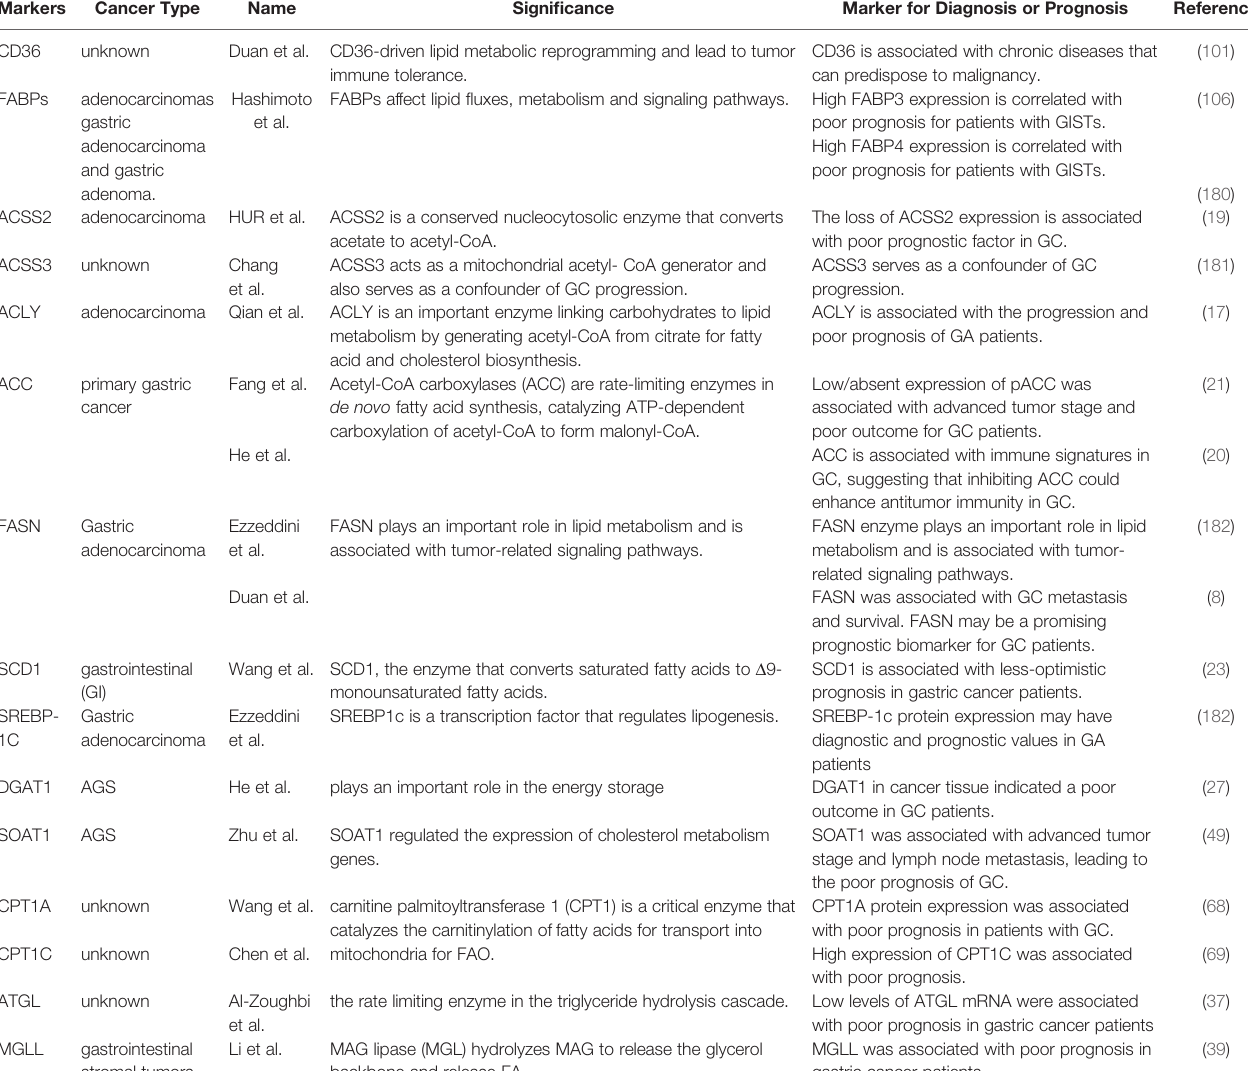
TABLE 5 | Lipid key enzymes as biomarkers for gastric cancer prognosis.